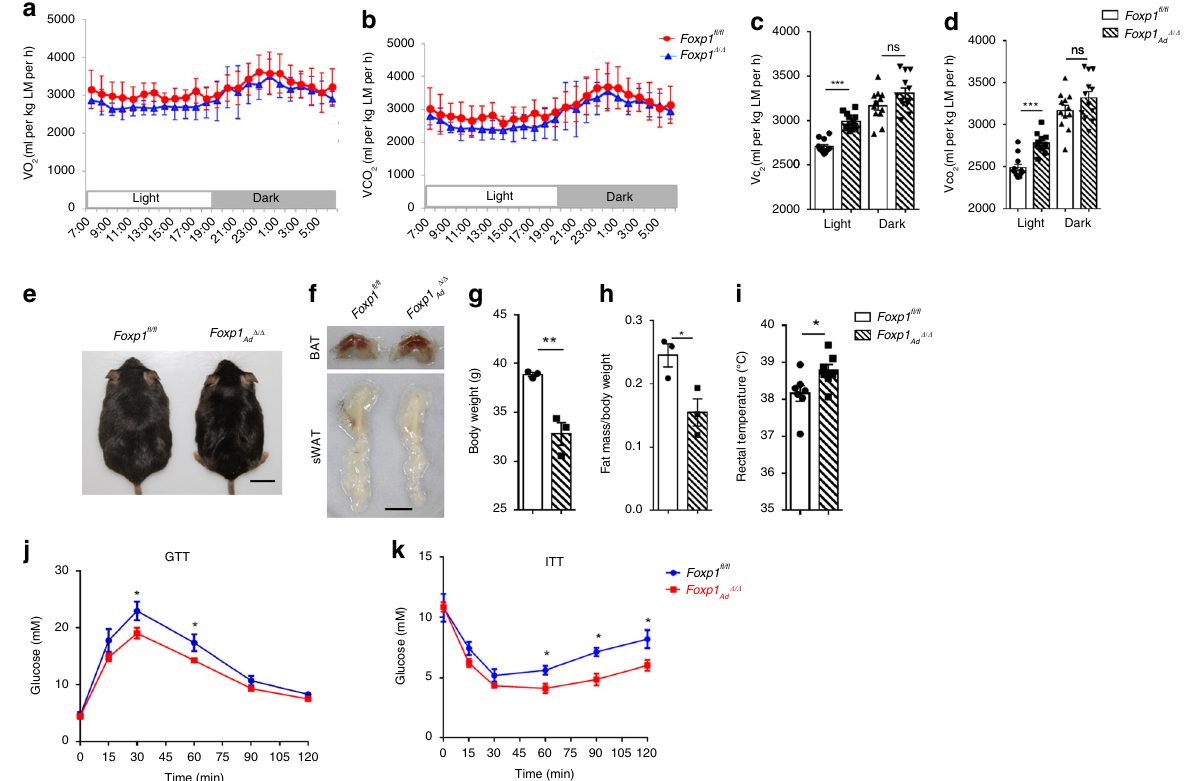
Fig. 3 Foxp1 deletion elevates energy expenditure and resists to HFD-induced obesity. a , b VO 2 and VCO 2 of Foxp1 fl / fl and Foxp1 Ad Δ / Δ mice in metabolic cages at age of 3 months old. n = 7 biologically independent mice/each group. c , d Quanti fi cation of O 2 and CO 2 consumption in light and dark. e Dorsal view of Foxp1 fl / fl and Foxp1 Ad Δ / Δ mice after 8-week feeding with HFD at age of 6 months old. Bar, 2 cm. f Representative depot of BAT and sWAT in HFD- fed mice ( e ). Bar, 1 cm. g Body weight of HFD-fed mice. h Relative adiposity of HFD-fed mice. i Statistics of rectal temperature of HFD-fed mice. j , k GTT and ITT of HFD-fed mice. * P < 0.05; ** P < 0.01; *** P < 0.001; n = 7 biologically independent mice/each group; error bar, mean ±